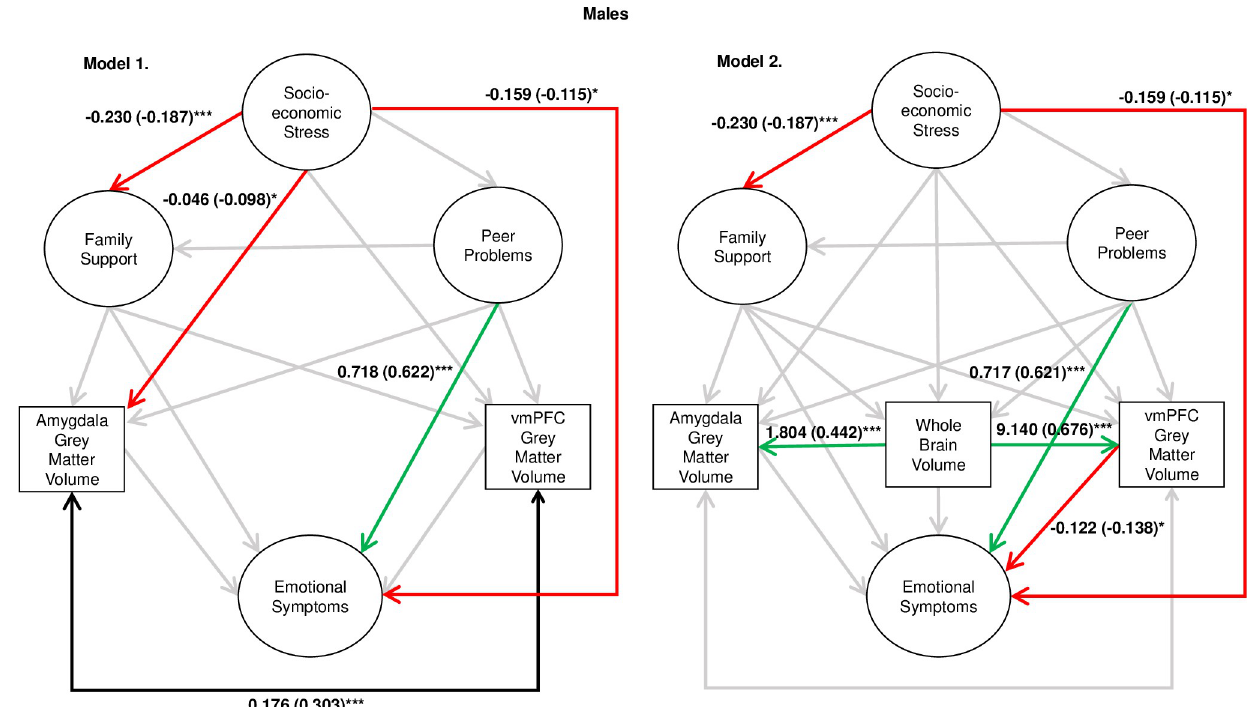
Fig 3. Results for models 1 and 2 for the male sample. Note. ��� = p < .001, �� = p < .01, � = p < .05. Estimates are unstandardised path coefficients (standardised in parentheses). Amygdala and vmPFC GMV values were divided by 1,000, and WBV was divided by 1,000,000, so that the values were closer in magnitude to other variables in the